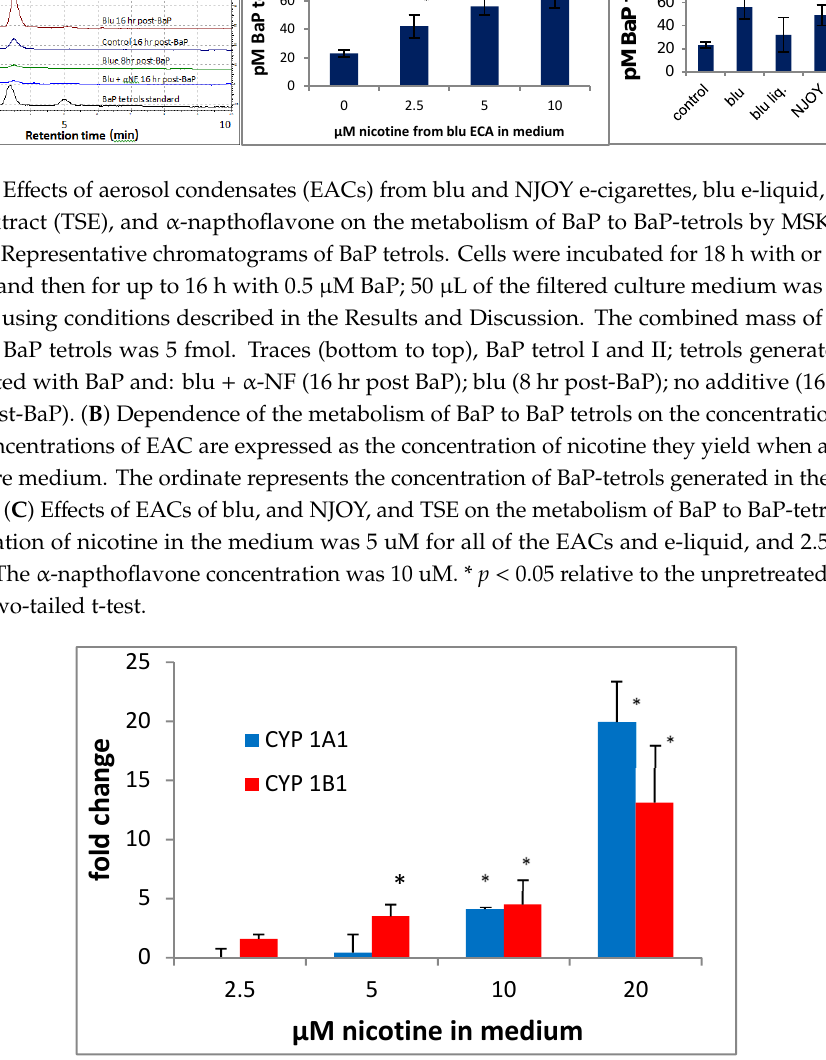
Figure 2. Effect of EAC from blu on CYP1A1 and 1B1 mRNA levels in MSK Leuk 1 cells. Cells were treated for 18 hr with the EAC such that every µ L of blu extract yielded 2.5 µ M nicotine/mL medium. RNA was then isolated, qPCR was performed, and Δ Ct values were normalized to LDH. * p < 0.05 relative to the unpretreated control, using a two-tailed t-test.